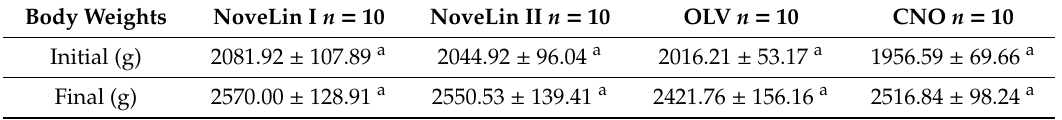
Table 3. Animal body weights (g) before and after 100 days of diet intervention.